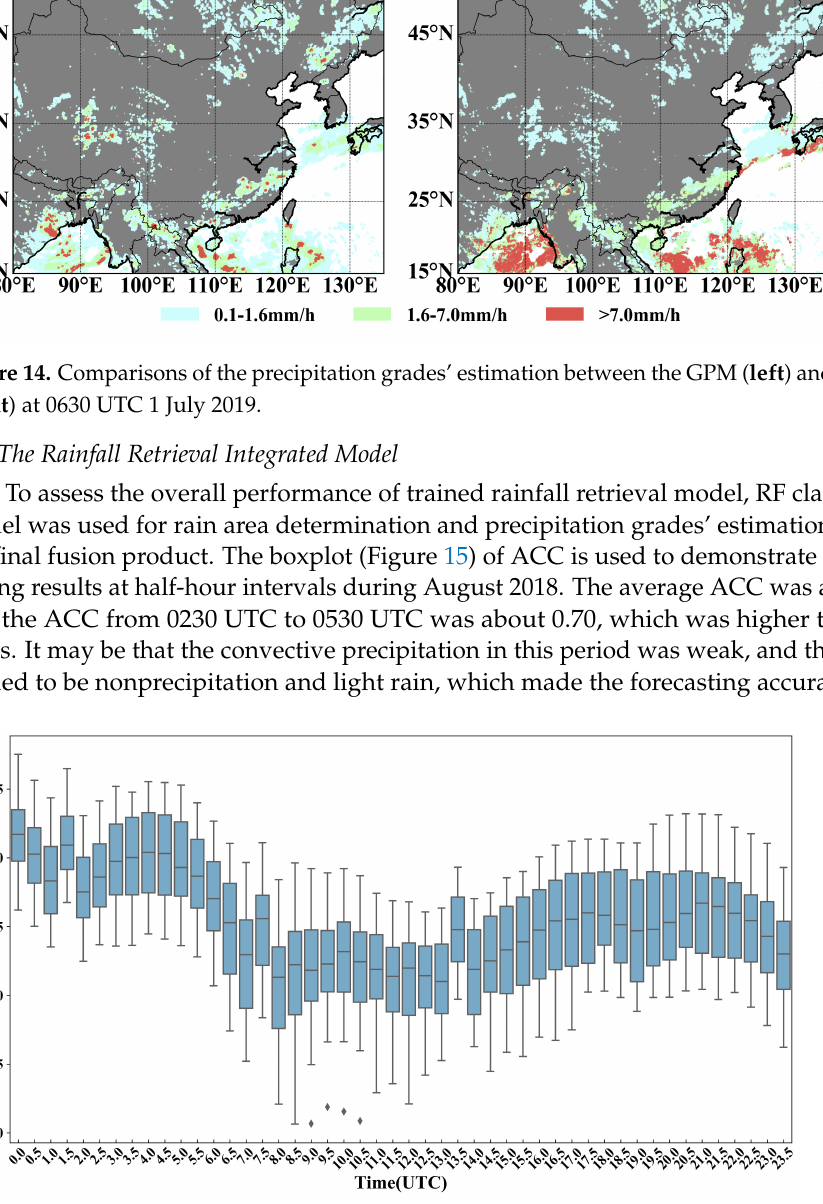
Figure 15. The diurnal variation of the accuracy for rainfall retrieval in the testing dataset during August 2018; the distributions of the statistical values by half-an-hour are interpreted in box plots. Box diagrams indicate the 25th, 50th, and 75th percentiles, whereas the periphery of the box extends to 1.5-times the quartile deviation (25th–75th percentile). Outliers are indicated by black